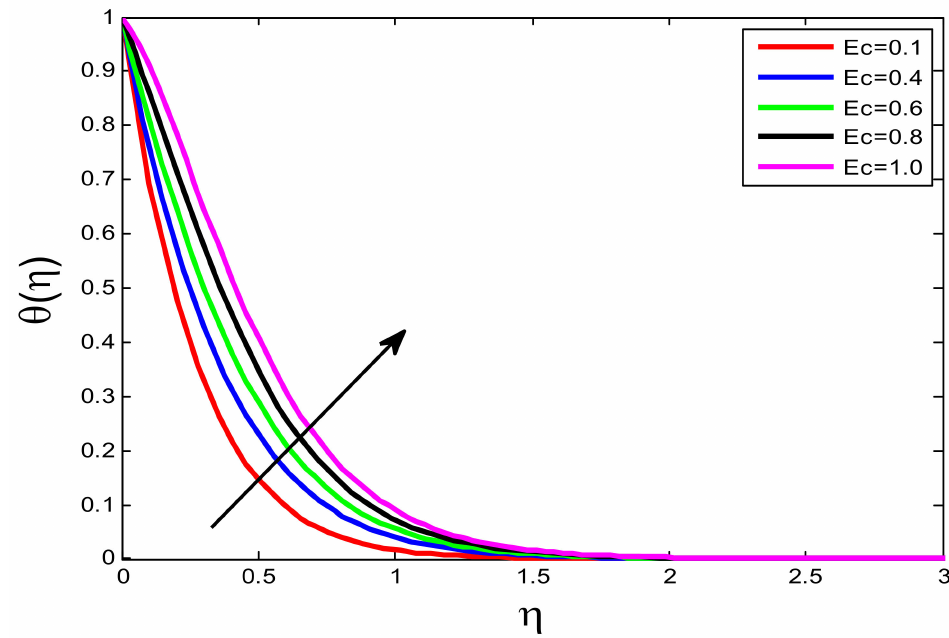
Figure 24. Influence of Ec on θ ( η ) .